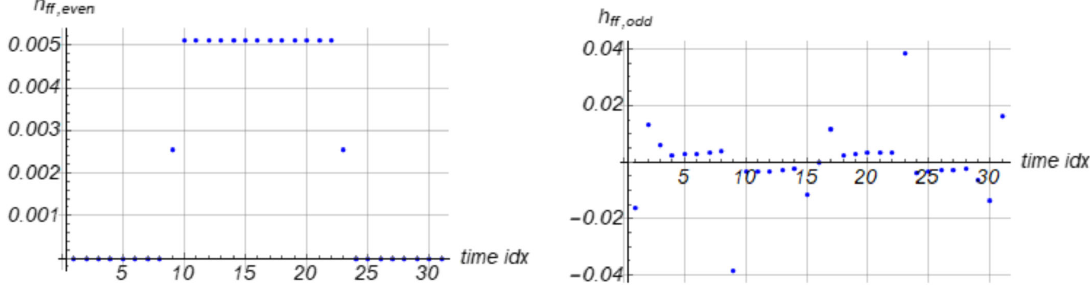
FIG. 29. Even-symmetric (left) and odd-symmetric impulse responses of the feedforward FIR filter.